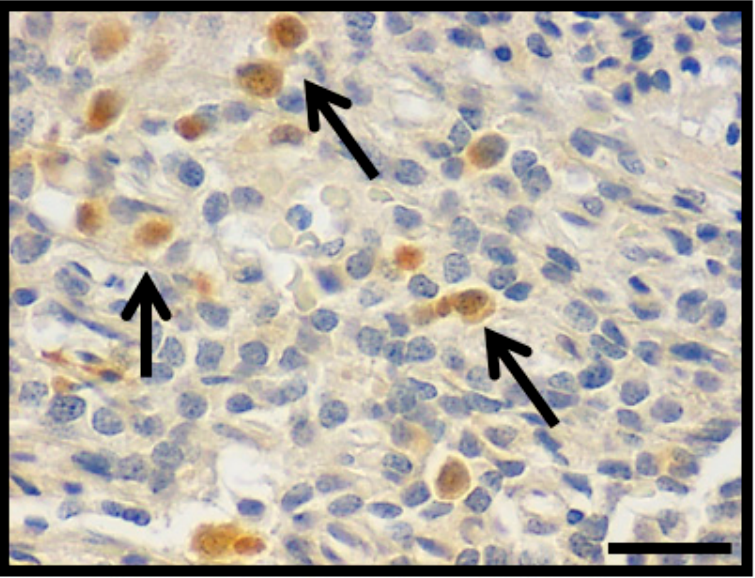
Figure 5. Photomicrograph showing the nuclear inmmunohistochemistry detection to Hint1 in PA (arrows; original magnification 400×, scale bar 250 μ m).